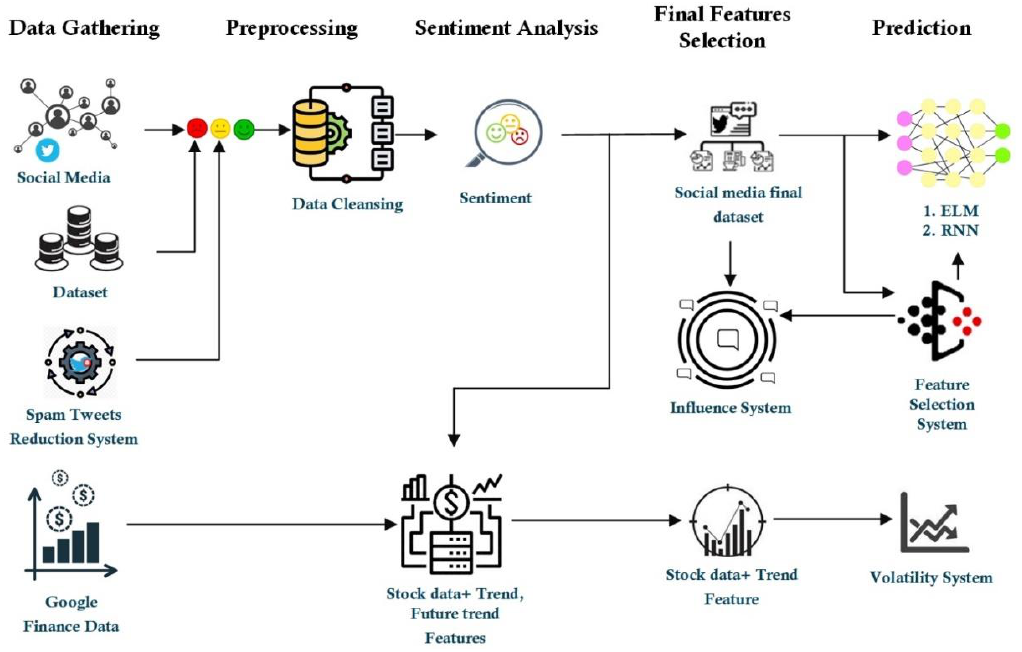
Figure 1. Flow diagram of proposed